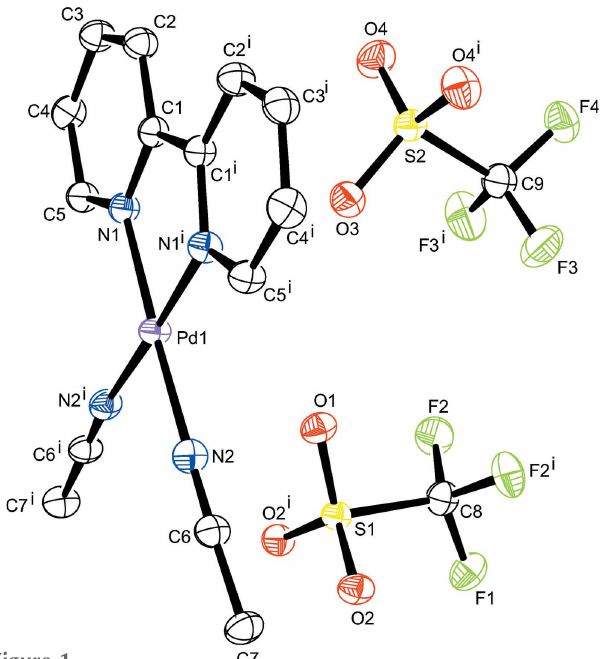
Figure 2 Perspective view of the packing structure of the title complex; H atoms are omitted for clarity.